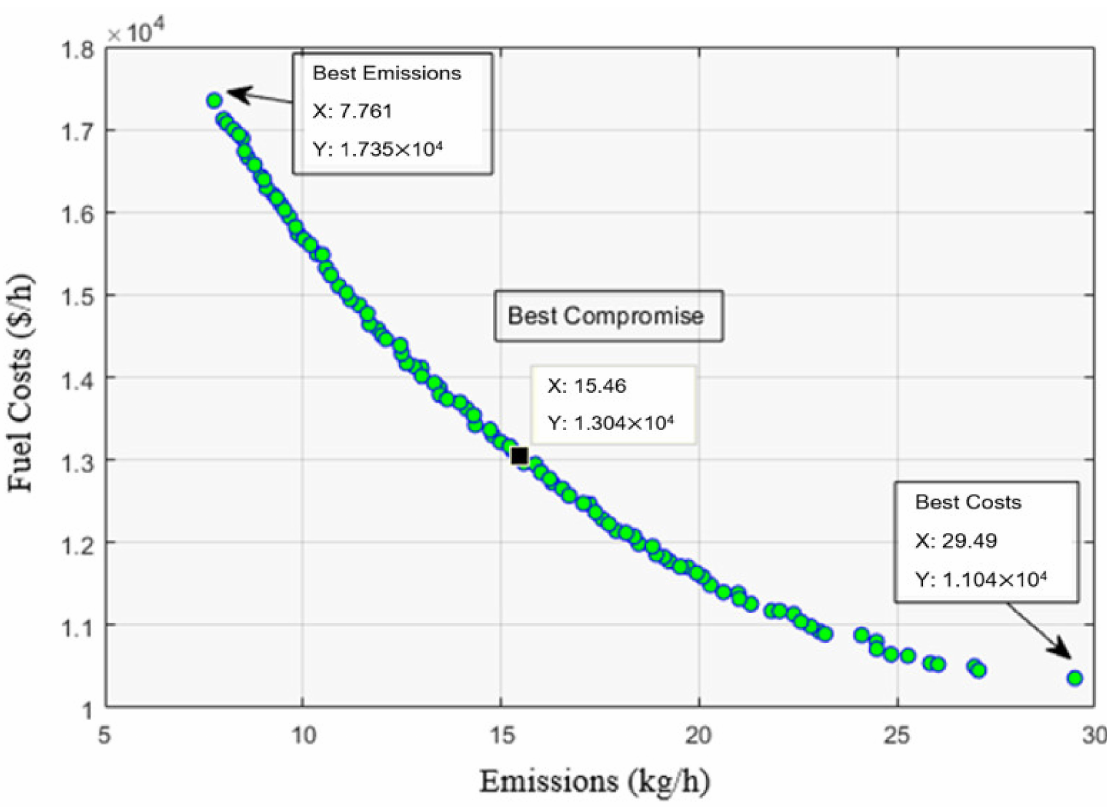
Figure 12. Final Pareto set with the proposed MTLSBA for the CHPEED